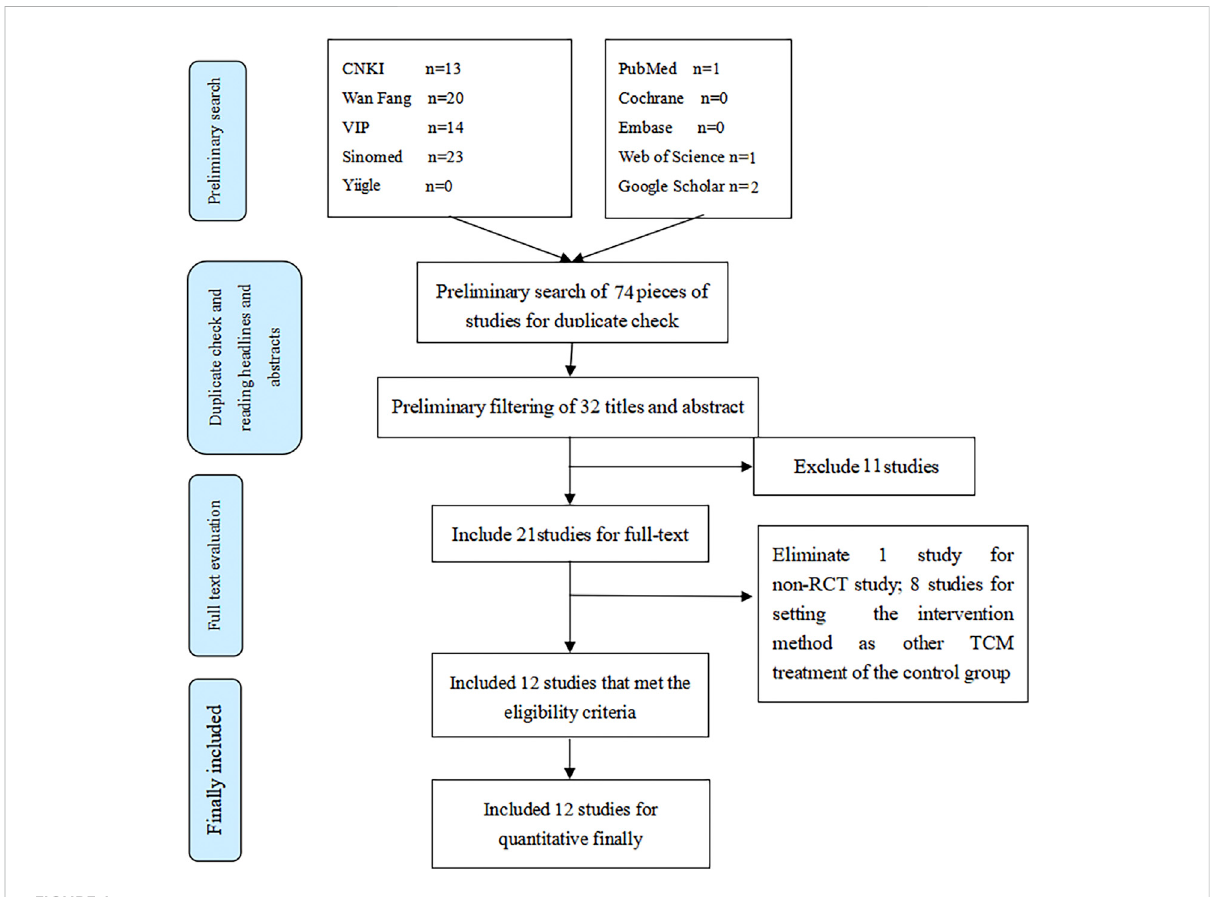
FIGURE 1 Flow diagram of the study